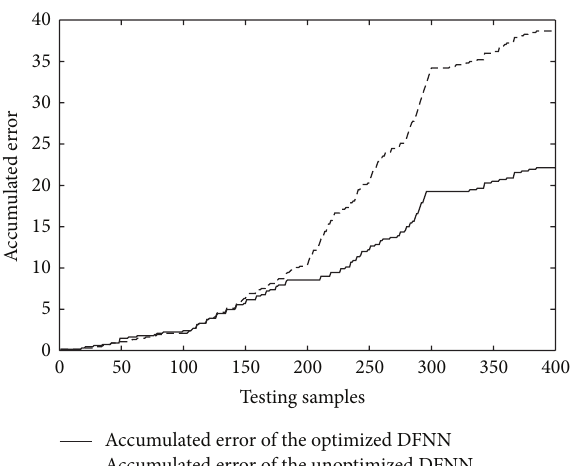
Figure 15: RBF neural network confusion matrix for training samples.